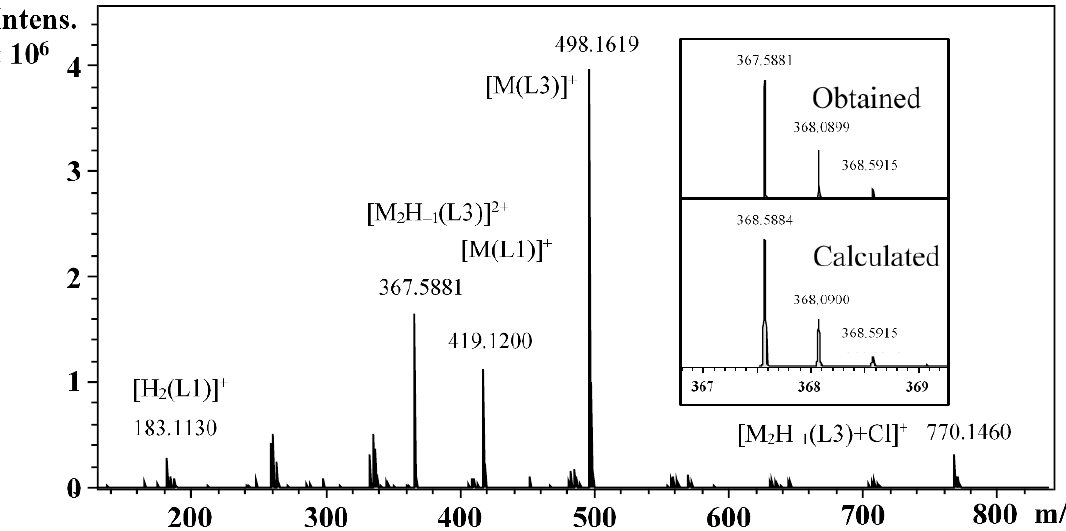
Figure 9. HR-ESI-TOF-MS spectrum registered in the [( η 5 -Cp*)Rh] 2+ –L3 system at 1:1 metal-ion-to-ligand ratio, pH = 7.0. Inlet shows the observed and calculated isotope pattern for [M 2 H –1 L] 2+ .